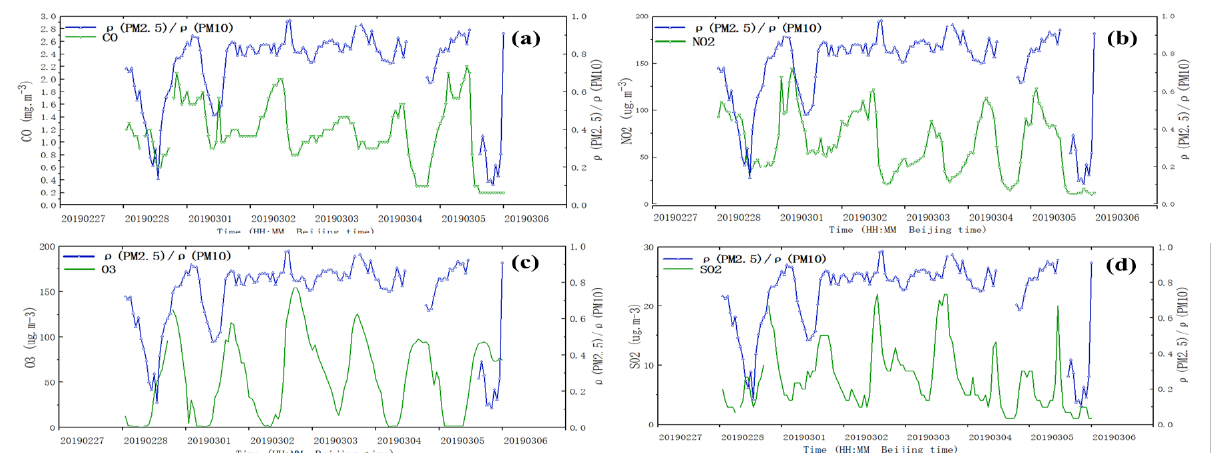
Figure 5. Concentrations of CO (a), NO2 (b), O3 (c) and SO2 (d) in Beijing from 28 January to 5 March